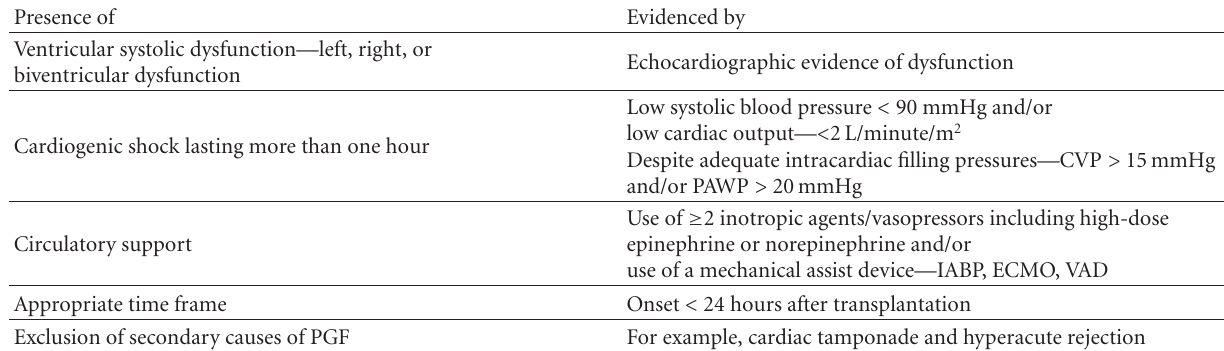
Table 1: Suggested diagnostic criteria for primary graft failure [7,